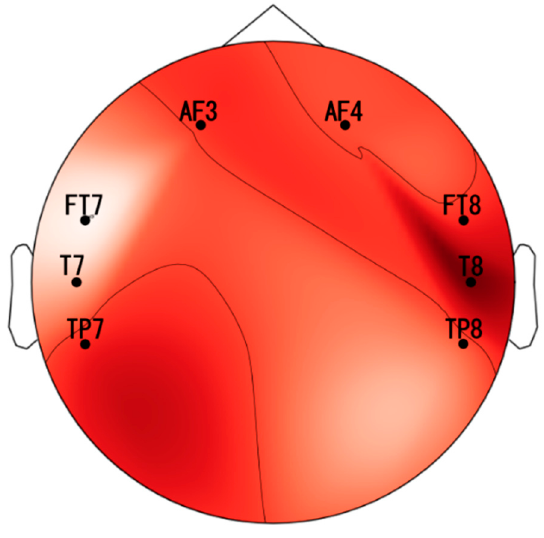
Figure 10. Topographical scalp map of the selected EEG electrodes.